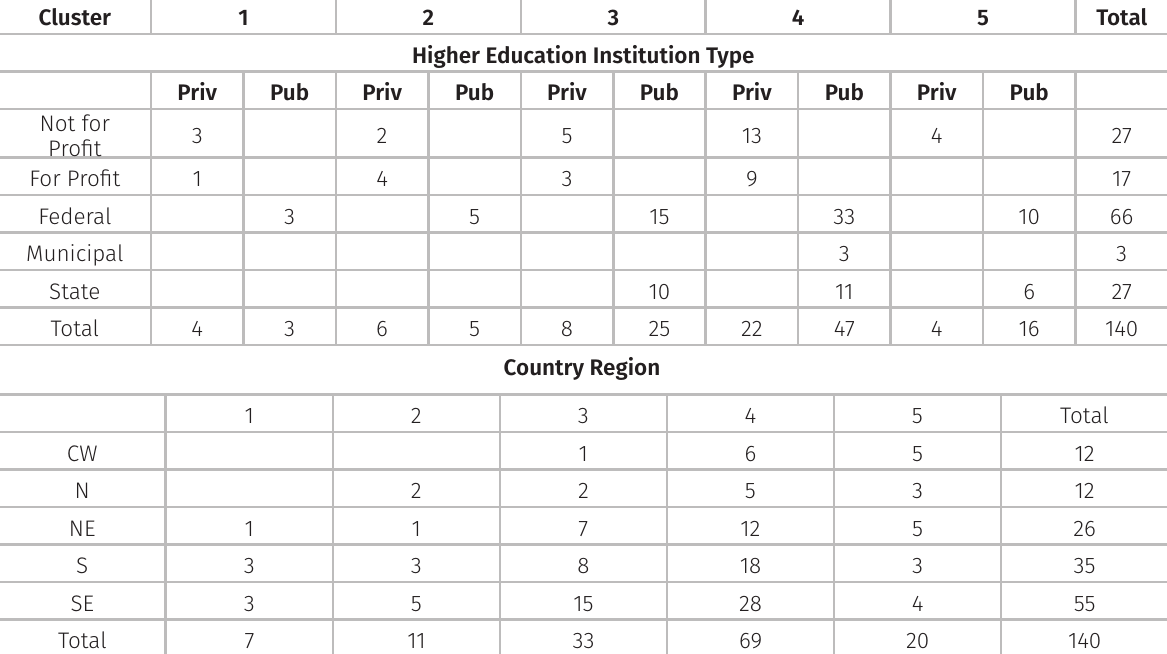
Table III. Type of Brazilian Higher Education Institutions and region by cluster (Priv – private; Pub – Public). Cluster